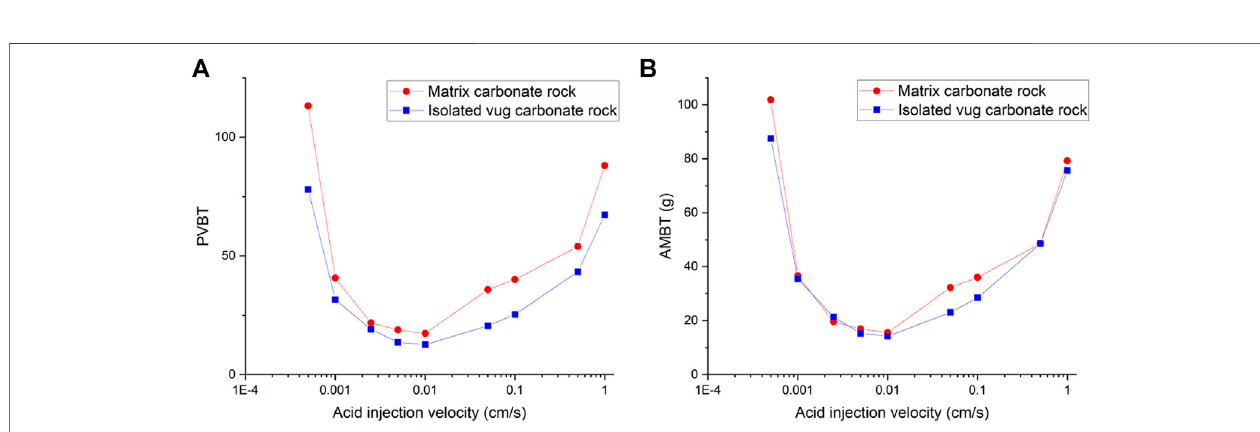
FIGURE 5 | Effect of the acid injection rate on acidizing curves of the isolated vug carbonate rock: (A) PVBT and (B) AMBT.